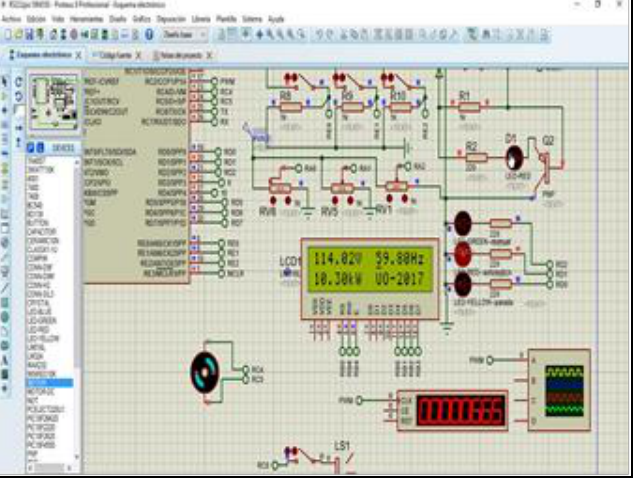
Figura 10: Modelo del regulador simulado en Proteus 8.6 , con bloque de configuración. Fuente: Los Autores, (2018).